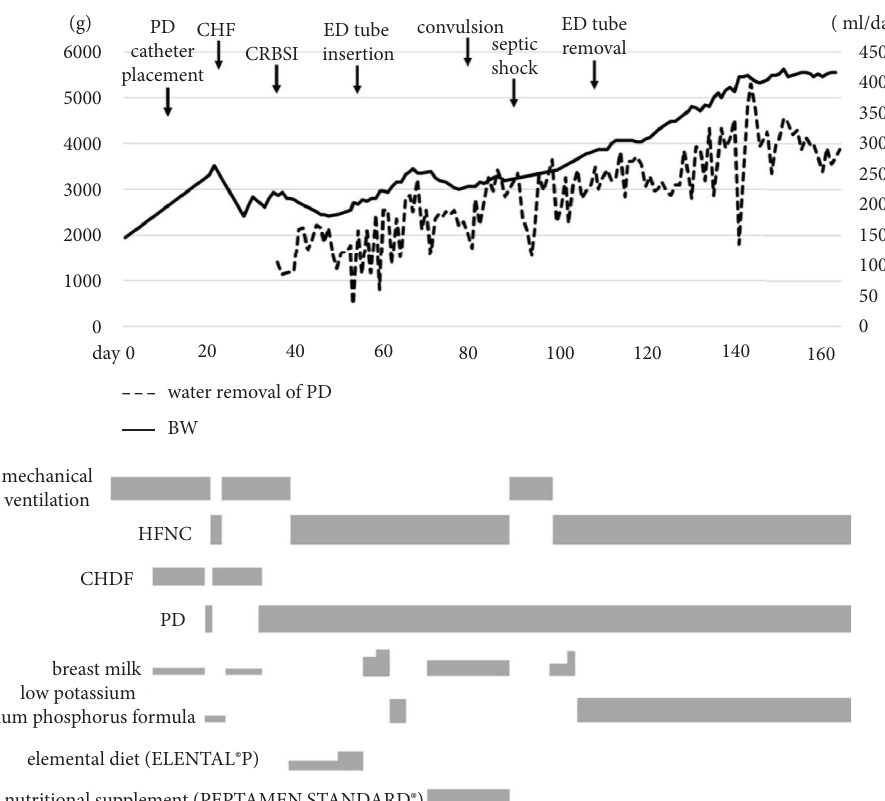
Figure 2: Clinical course from birth to discharge. Te patient was extubated at 18days of age and was reintubated at 24days of age due to CHF-caused poor water removal. After water removal by PD became stable, she was extubated at 36days of age and respiratory support was performed by HFNC. Elemental diet (ELENTAL ® P) was also used in addition to breast milk and low potassium medium phosphorus formula, but enteral nutrition did not progress, so an ED tube was inserted at 53days of age. Nutrition gradually increased and was aided by the high-protein digestive nutritional supplement (PEPTAMEN STANDARD ® ). After removing the ED tube, nutrition encompassed breast milk and later switched to the low potassium medium phosphorus formula. Te preparation concentration of low potassium medium phosphorus formula gradually increased from 15% to 18%. During the course, complications such as CRBSI, septic shock, and convulsion occurred but were controlled by treatment. BW, body weight; PD, peritoneal dialysis; CHF, congestive heart failure; CRBSI, catheter-related blood stream infection; HFNC, high-fow nasal canula; ED, elemental diet; CHD, continuous hemodialysis.